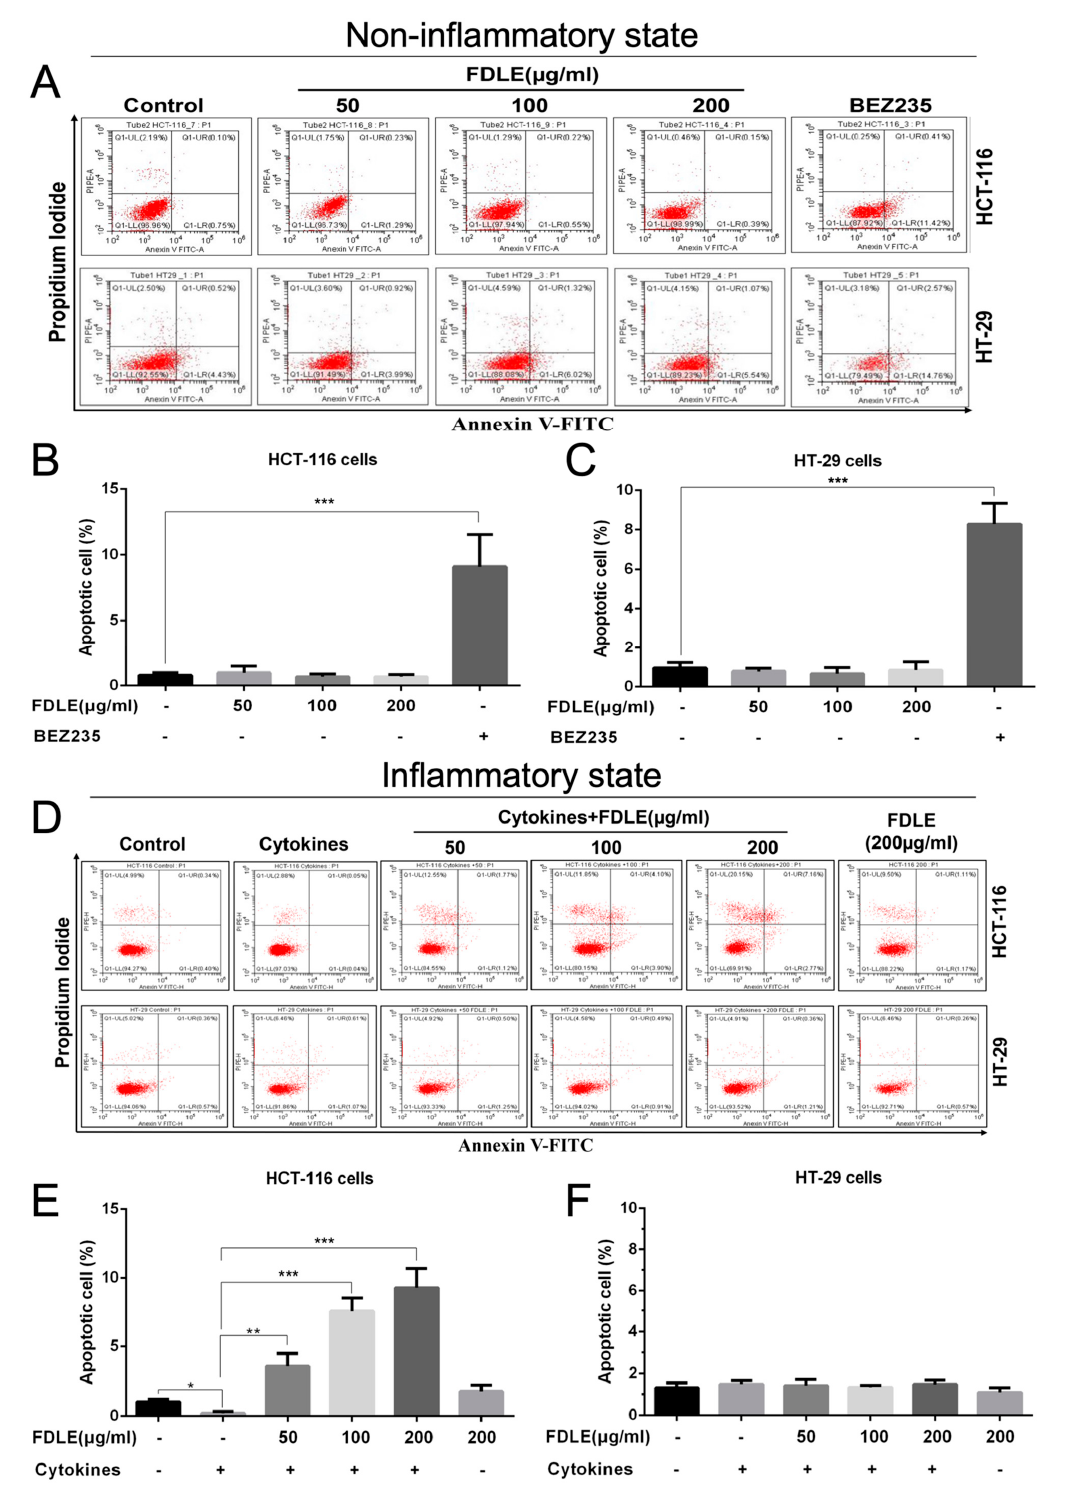
Figure 6. The effects of FDLE on apoptosis induction in non-inflammatory and inflammatory HCT- 116 and HT-29 colorectal cancer cell lines. Apoptosis includes early apoptosis (LR) and late apoptosis (UR). ( A – C ) Apoptosis rate of non-inflammatory HCT-116 and HT-29 cells treated with three doses (50, 100 and 200 µ g/mL) of FDLE for 48 h. ( D – F ) Apoptosis rate of inflammatory HCT-116 and HT-29 cells treated with three doses (50, 100 and 200 µ g/mL) of FDLE for 48 h after adding a mixture of cytokines (TNF- α , IFN- γ and LPS each 10 ng/mL) for 2 h. The results were represented as mean ± SD of three independent experiments, * p < 0.05, ** p < 0.01, *** p <